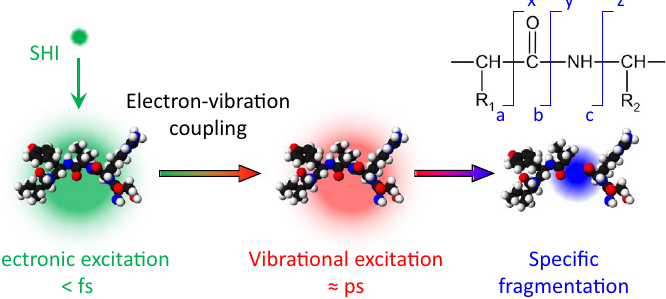
Figure 7. Schematic illustration of SHI-induced excitation and fragmentation of oligopeptides via coupling between the electronic and vibrational excitation. The impinging SHI leads to excitation of the electronic subsystem only (sub-femtosecond timescale). The electronic excitation is converted into highly vibrationally excited molecules on the picosecond timescale. As a consequence, the covalent bonds most prone to